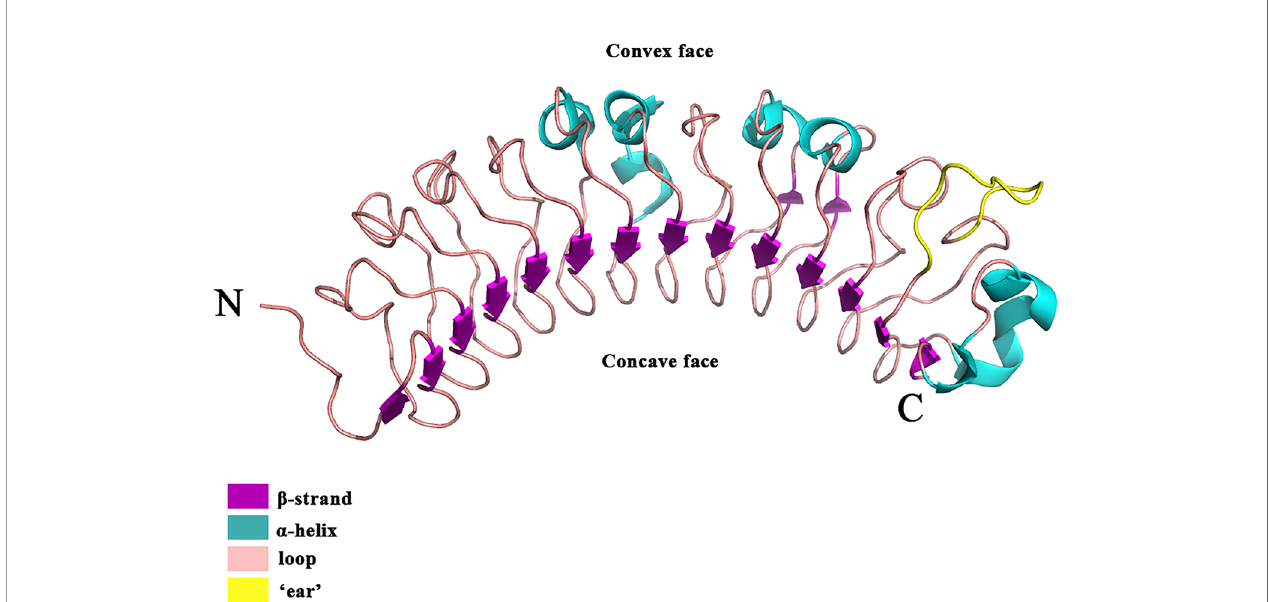
FIGURE 2 | The crystal structure of the DCN. DCN is the archetypal SLRP [the structure was retrieved from Protein Data Bank (PDB), ID: 1XKU] (Scott et al., 2004). DCN is a single-domain structure with a righthanded, curved solenoid fold characteristic of LRR proteins. The long b -sheet that forms the inner, concave face is comprised of 14 b -strands. The penultimate LRR that extends laterally from the main body of the molecule is referred to as the ‘ ear ’ (yellow) repeat, which is thought to be a distinctive feature of the SLRP